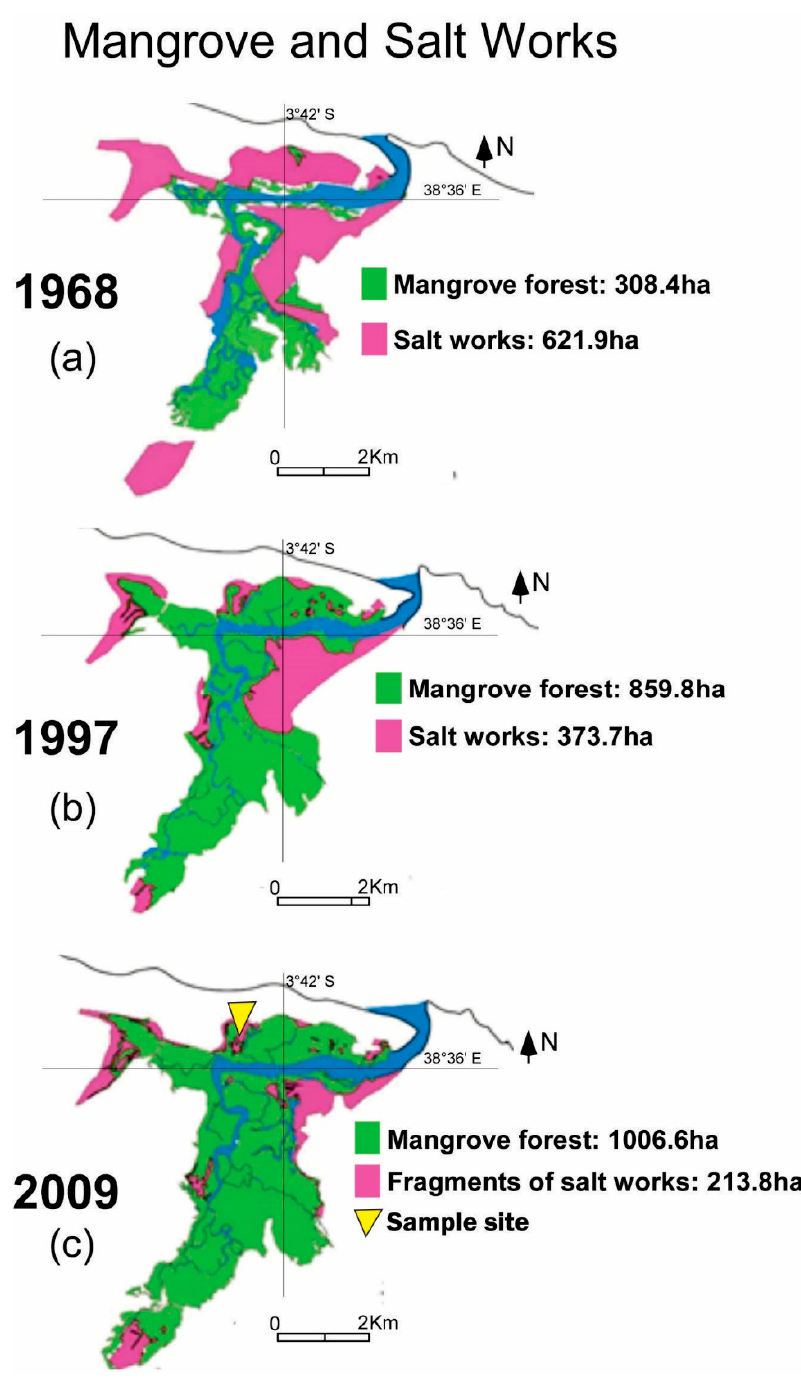
Figure 2. Thematic maps showing the areas of mangrove forest (in green) and the saltworks (in pink) in the estuary of the Cear á River in 1968 ( a ), 1997, ( b ) and 2009 ( c ). The figure shows in different periods how mangrove has expanded into abandoned salt work